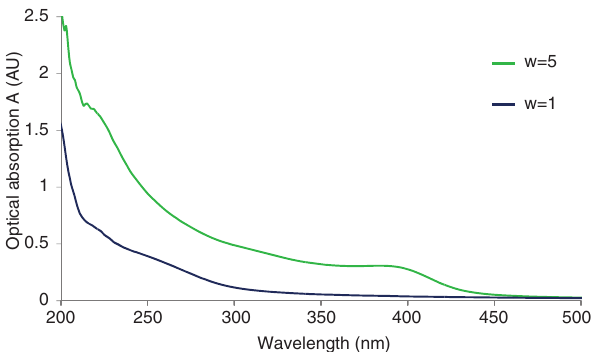
Figure 5 Absorption spectra of Rh RadChem NPs (Dose = 15 kGy) in reversed micellar solutions at ω (upper curve).